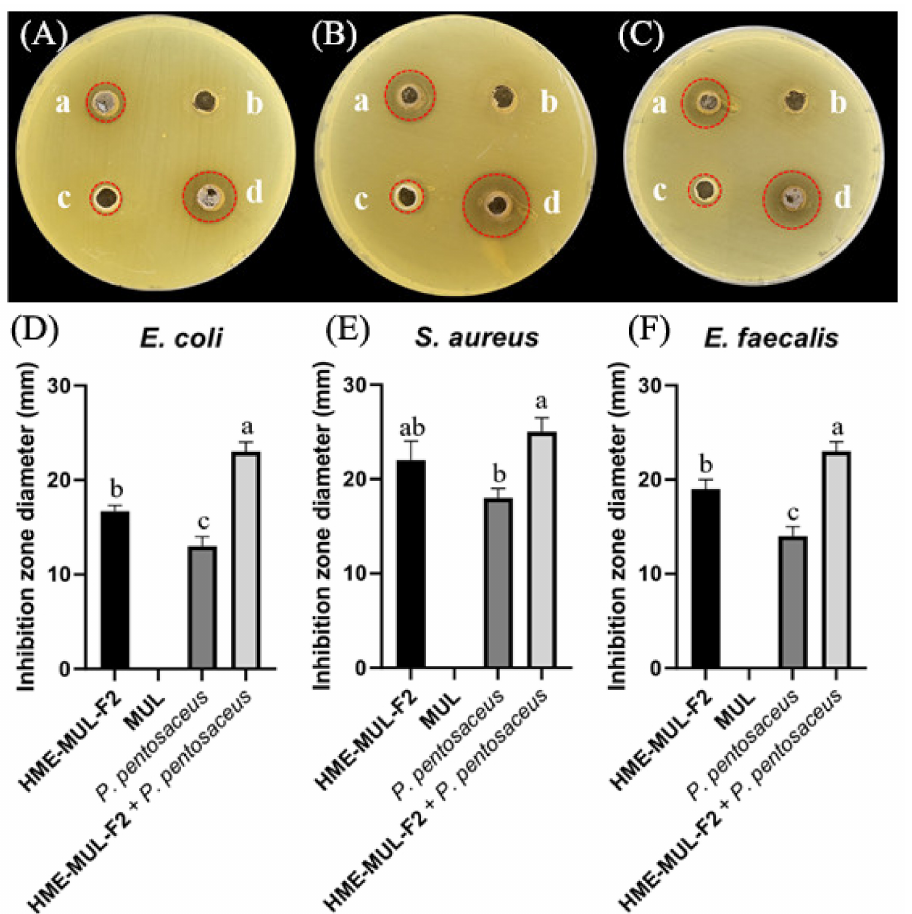
Figure 11. Inhibition zones in the presence of probiotics P. pentosaceus against test pathogens after treatment with HME-DDS formulation (HME-MUL-F2). ( A , D ): Inhibition against E. coli. ( B , E ): In- hibition against S. aureus . ( C , F ): Inhibition against E. faecalis . a: treatment with